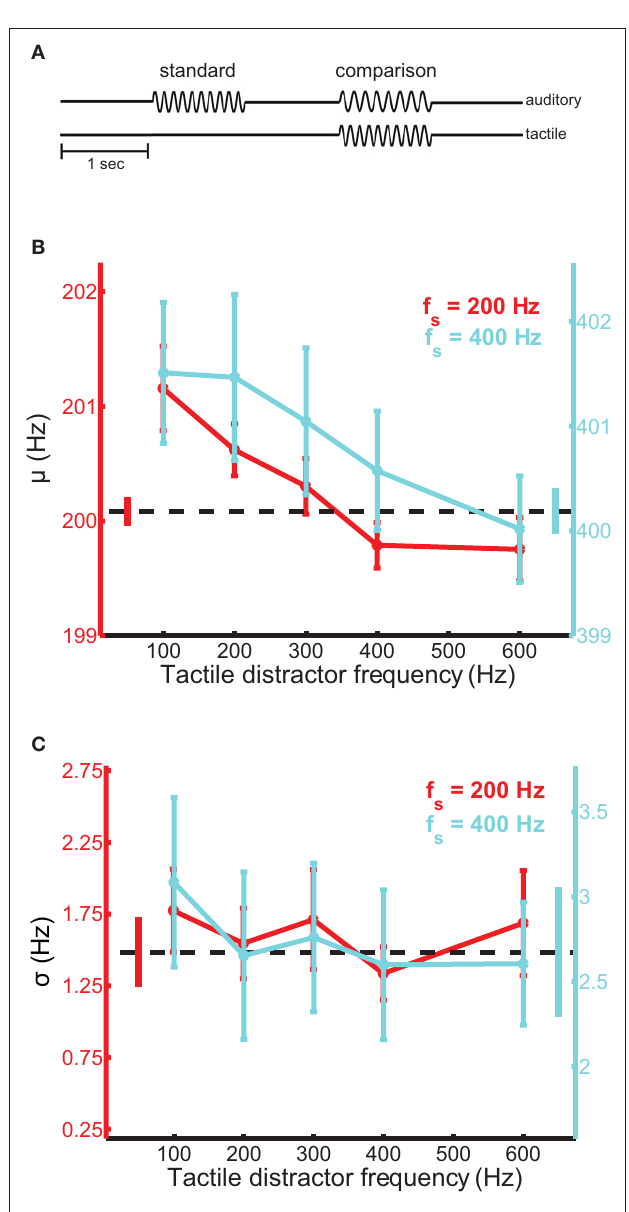
Figure 1 | Auditory frequency discrimination in the presence of tactile distractors. (A) Experimental design. Tactile distractors were delivered in the interval containing the comparison stimulus, which was randomized across trials. (B) Mean bias estimates (PSE) averaged across participants in the frequency discrimination experiments with the 200-Hz (red trace) and 400-Hz (cyan trace) standards, as a function of distractor frequency. The black dashed line and untethered bars correspond to baseline and SEM, respectively. Error bars indicate SEM. Bias estimates were significantly modulated by distractor frequency. (C) Mean sensitivity estimates averaged across participants in the frequency discrimination experiments. Conventions as in (B) . Sensitivity did not depend on distractor